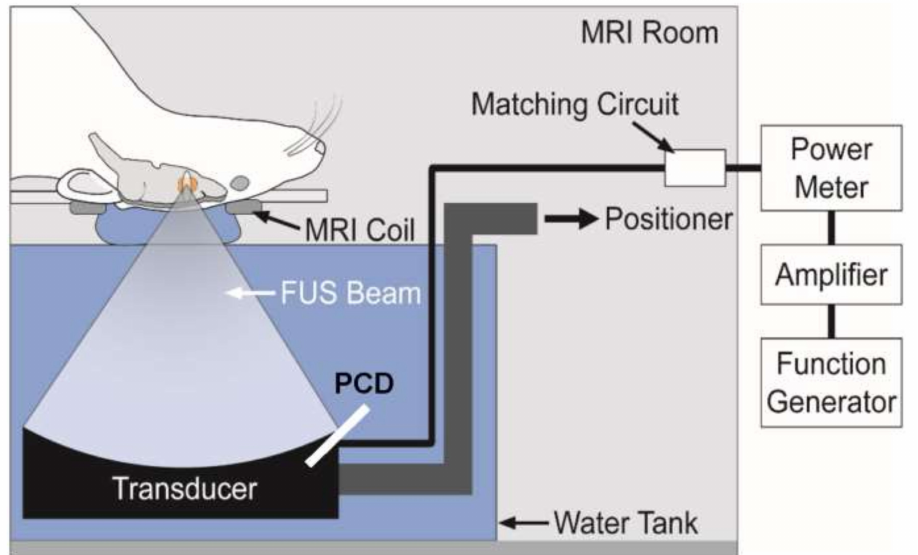
Figure 4. Schematic representation of the MRI-guided FUS system used by Park et al. Reprinted from Ref. [138], PLOS,